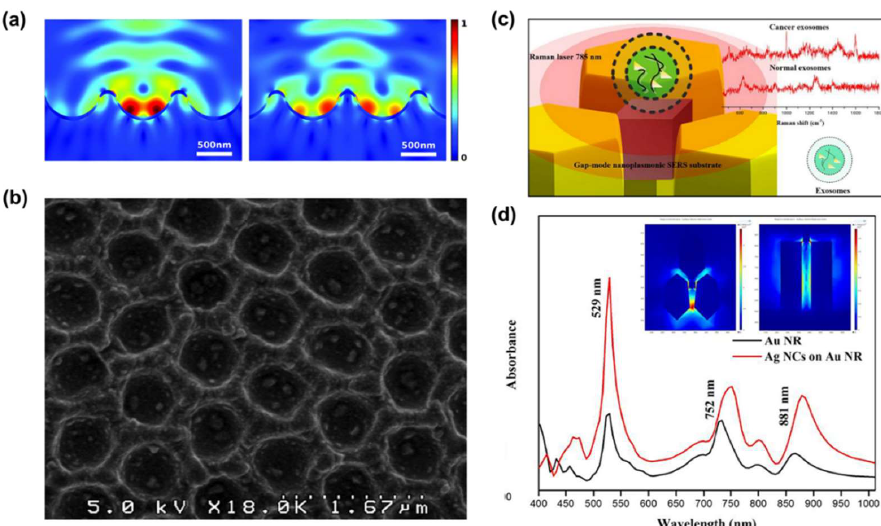
Figure 3. Nanostructures for the label-free SERS of dried EVs. ( a ) Electromagnetic field enhancement factor (EFEF) simulation results of the 3D plasmonic nanobowl when the laser is focused on the center of the nanobowl (left) and the outer wall of the nanobowl (right). ( b ) Scanning electron microscopy (SEM) image of a nanobowl platform with 100 nm polystyrene beads trapped inside the bowls. Reproduced from Ref. [29] with permission from The Royal Society of Chemistry. ( c ) Schematic concept of bimetallic plasmonic gap-mode SERS. ( d ) Surface plasmon resonance spectrum of the AuNR and AgNC-AuNR structures. The inset images show the local EM field distribution of bimetallic nanogaps (left: top view, right: side view). Adapted from Ref. [49], Copyright 2017, with permission from Elsevier.